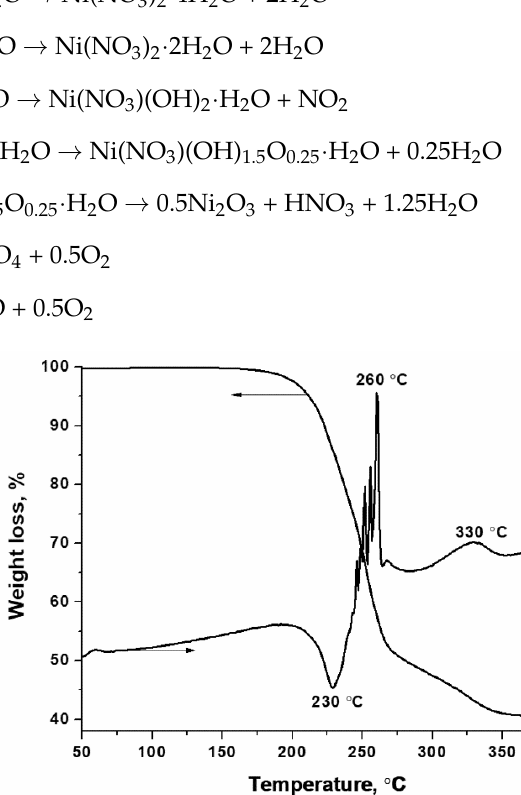
Figure 3. Thermal decomposition of the synthesized hexakis-(imidazole) nickel (II) nitrate complex (helium, 5 °C·min − 1 ). (helium, 5 ◦ C · min − 1